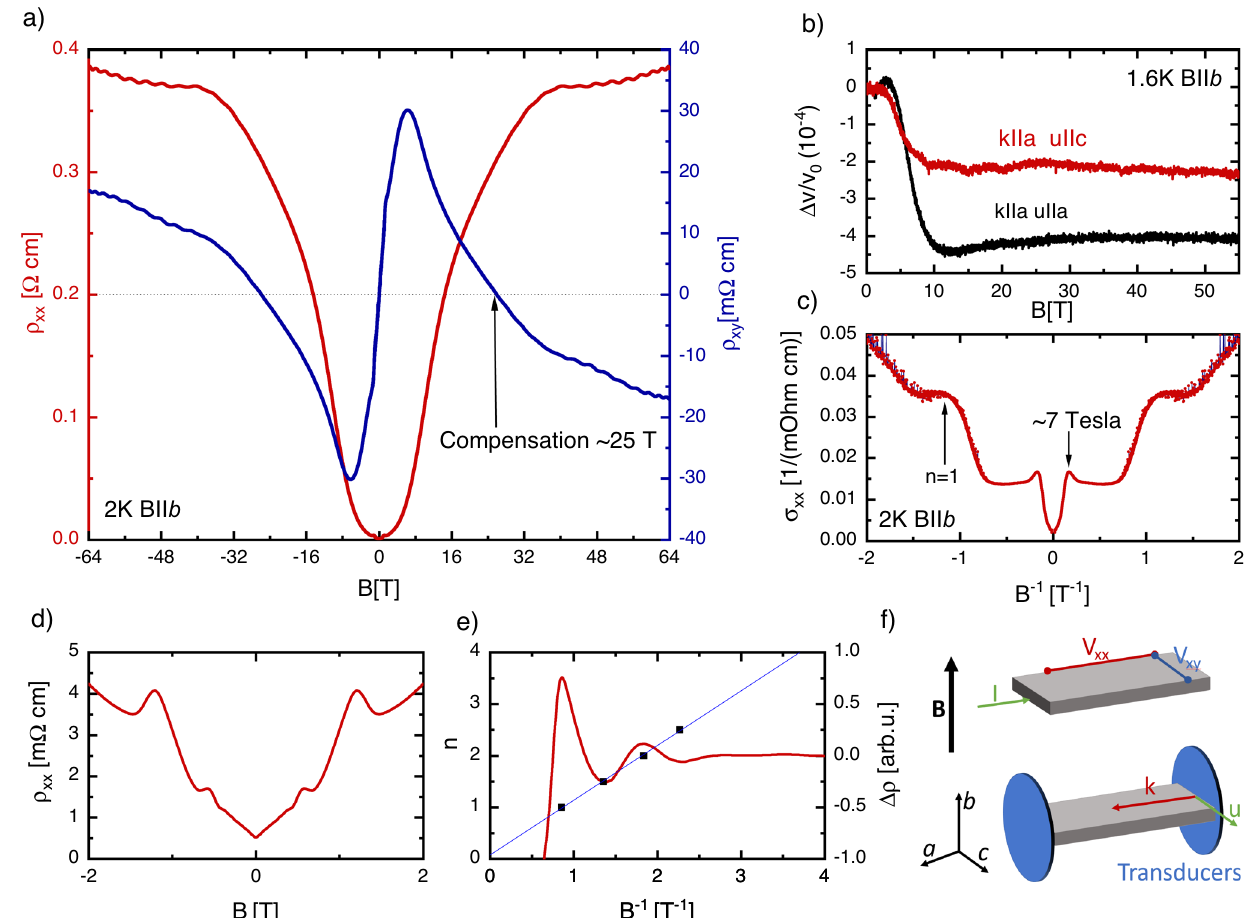
Fig. 1 | High- fi eld electrical charge transport in ZrTe5 at 2K. a Longitudinal resistivityandHalleffectmeasuredinsampleAinpulsedmagnetic fi eldsat2K,the arrow marks the point at which ρ xy =0. b Sound – velocity variation Δ v / v 0 of a longitudinal(black)and transverse (red)sound modepropagatingalong the a -axis asa function of magnetic fi eld applied along the b -axis of Sample B at1.6K. c Field dependence of the electrical conductivity of Sample A extracted by inverting the